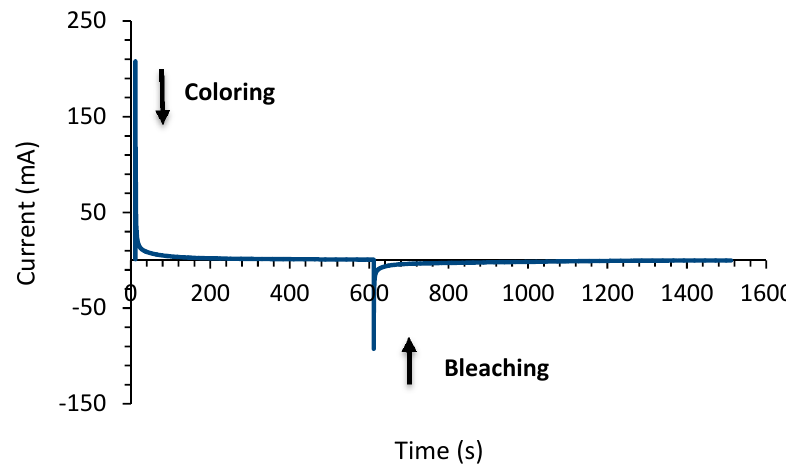
Figure 8. Chronoamperometry curve of the electrochromic cell appearing both at the bleached and the tinted states.